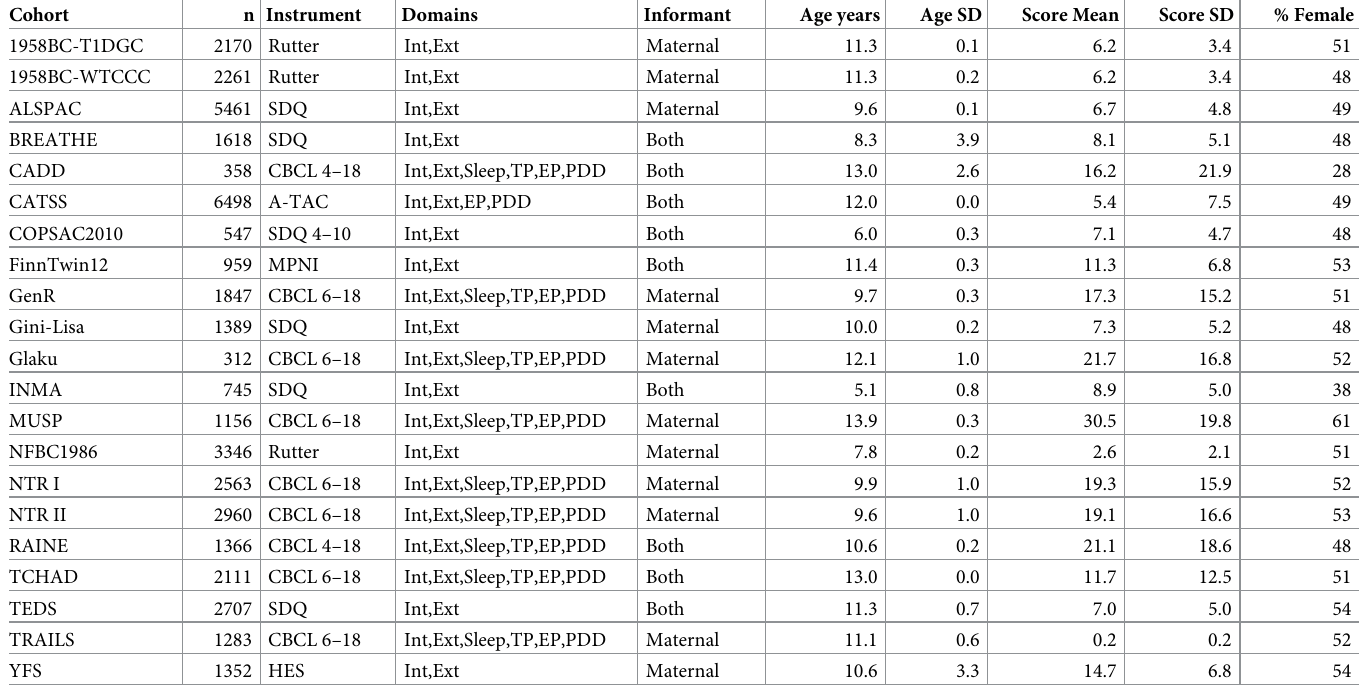
Table 1. Phenotype